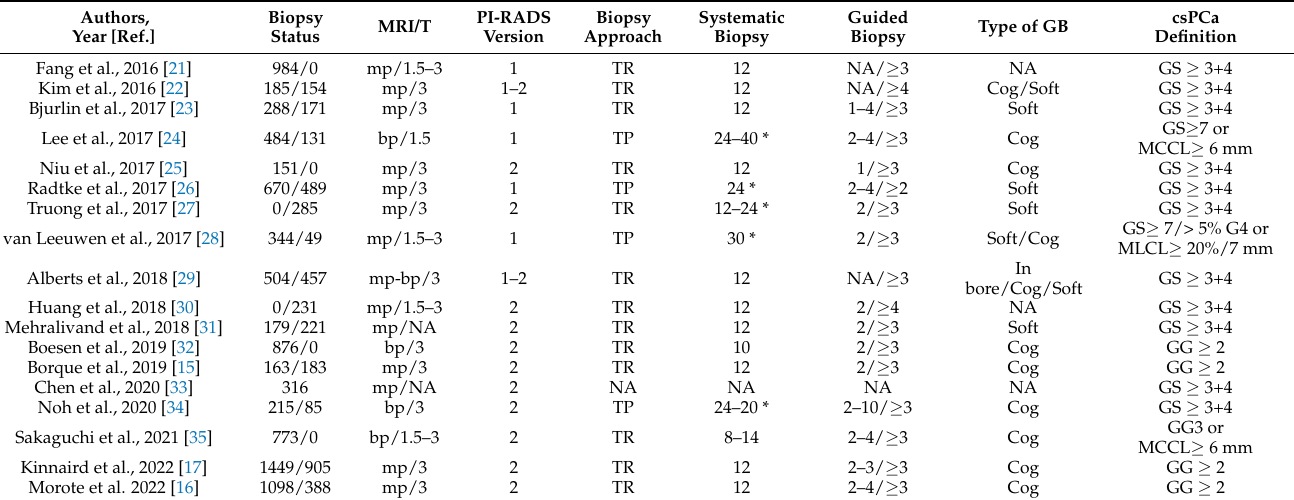
Table 1. Biopsy status and size of development cohorts, characteristics of pre-biopsy MRI, prostate biopsy approaches and types of systematic and guided biopsies, and csPCa definitions. Authors, Year